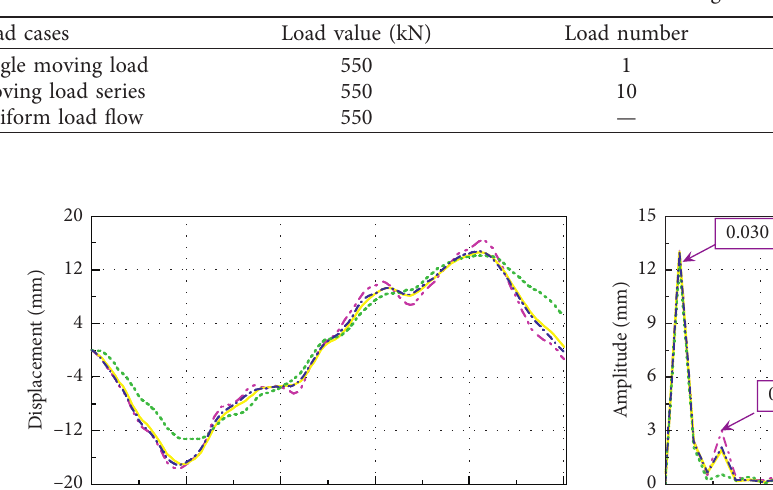
Table 5: Cases of different moving loads.